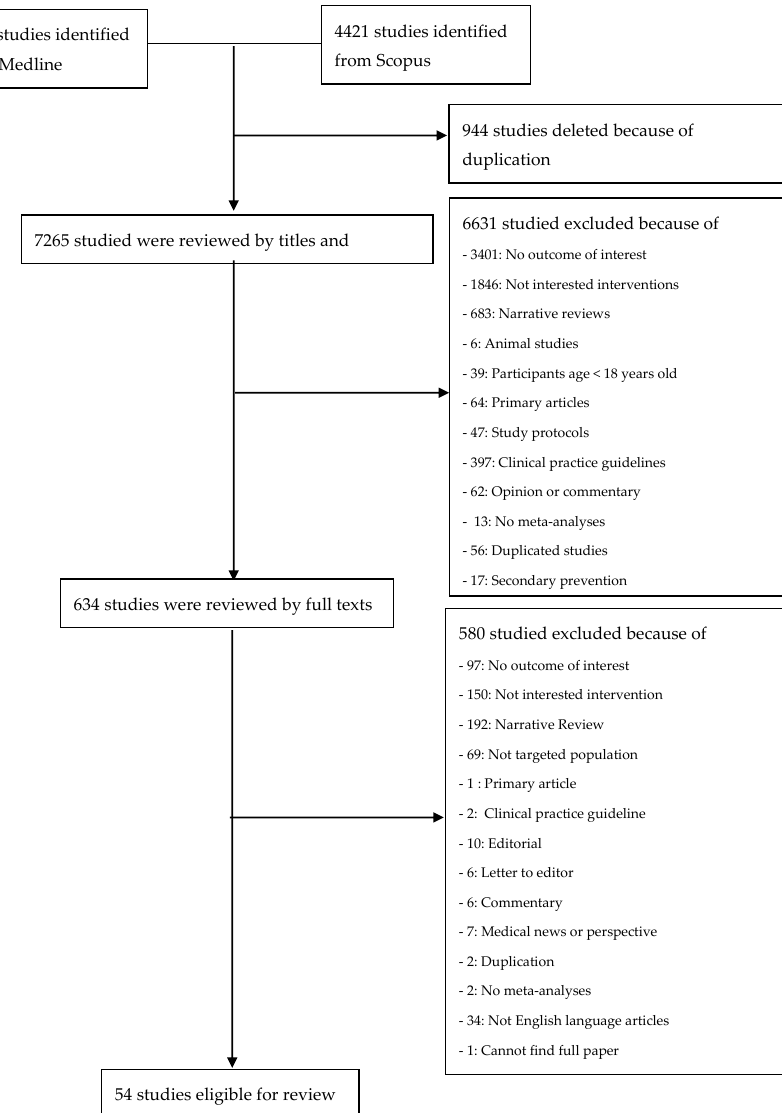
Figure 1. Flow chart of study selection.